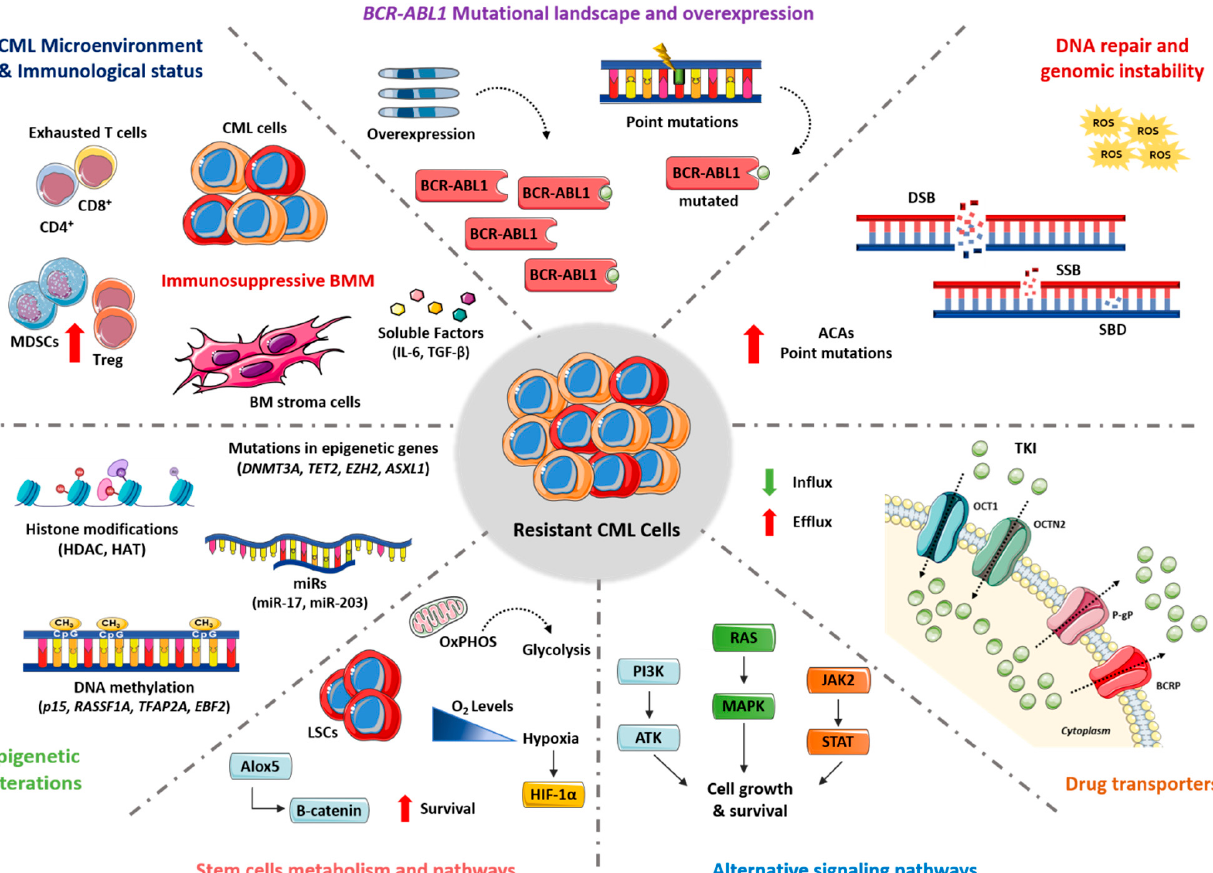
Figure 1. Molecular mechanisms of resistance to TKIs in CML. The molecular mechanisms responsible for TKI resistance in CML include: BCR-ABL1 mutations and BCR-ABL1 overexpression; alteration of DNA damage repair and genomic instability (increasing the additional chromosome abnormalities (ACAs) and point mutations); changes in drug transporters activity (e.g., increased efflux and decreased influx); activation of alternative signaling pathways (e.g., PI3K/AKT, JAK/STAT, and RAS/MAPK); changes in leukemia stem-cell metabolism and pathways (e.g., metabolic shift, Hypoxia/HIF-1 α , and Alox5/ β -catenin); epigenetic alterations (e.g., mutations on epigenetic regulating genes such as DNMT3A and/or increased methylation of p15 and EBF2 genes); altered expression of microRNAs (e.g., miR-17 and miR-203); changes in the microenvironment and immunological status (e.g., immunosuppressive bone marrow microenvironment (BMM) with increased MDSCs and Treg, plus exhausted T cells).